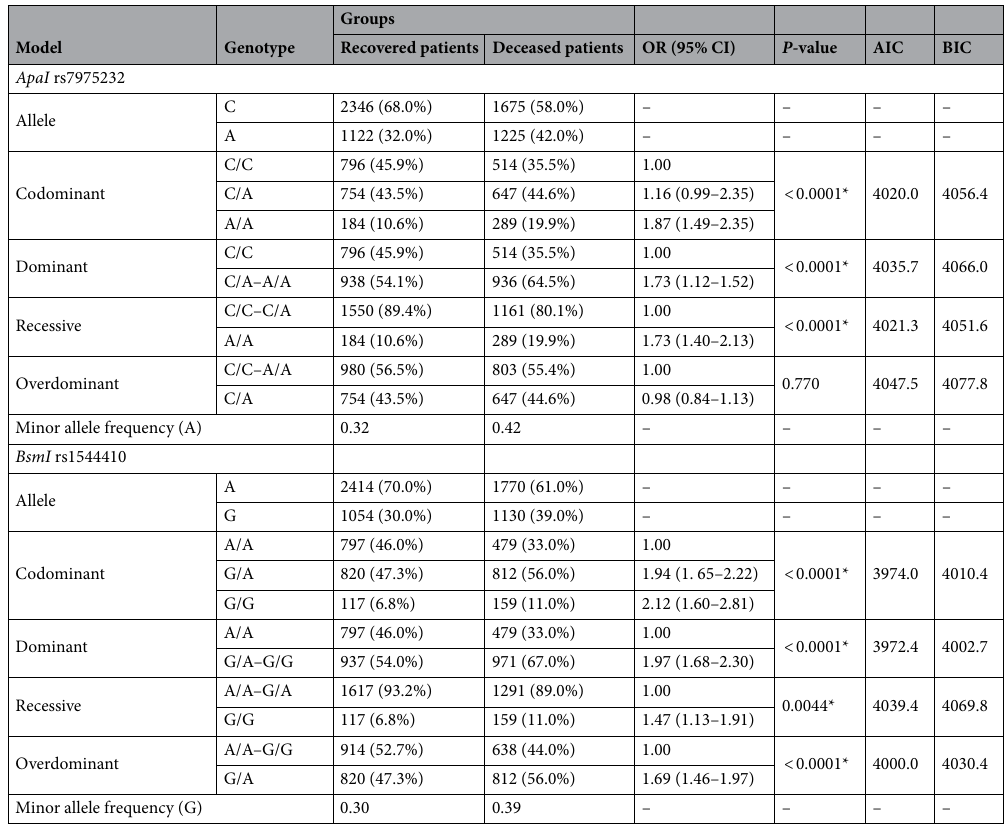
Table 2. ApaI rs7975232 and BsmI rs1544410 polymorphisms association with COVID-19 mortality adjusted by SARS- CoV-2 variants. COVID-19 coronavirus disease, SARS-CoV-2 Severe Acute Respiratory Syndrome Coronavirus 2, OR odds ratios, CI confidence intervals, AIC Akaike information criterion, BIC Bayesian information criterion, OR odds ratios, CI confidence intervals. *Statistically significant (<